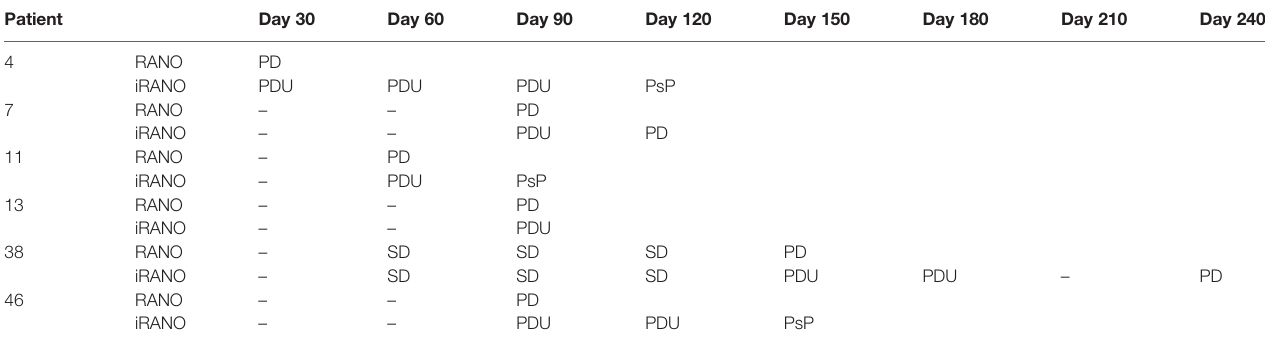
TABLE 3B | Group 2 representing six patients with recurrent GBM with discordant PD date by RANO vs iRANO (PD by RANO and PDU by iRANO.